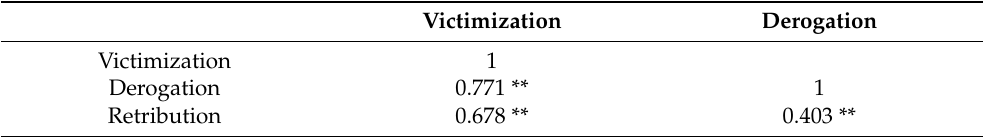
Table 4. Pearson’s correlation coefficients in the ABA-SF scale.